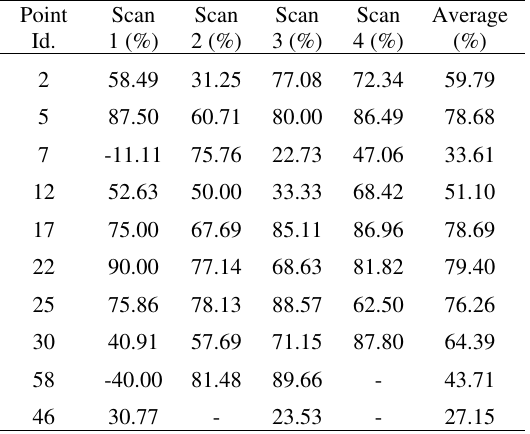
Table 6. RMS of residuals on the targets calculated for each scan station before calibration (Initial RMS after registration, column 2) and RMS after calibration (Adjustment 5, column 3).